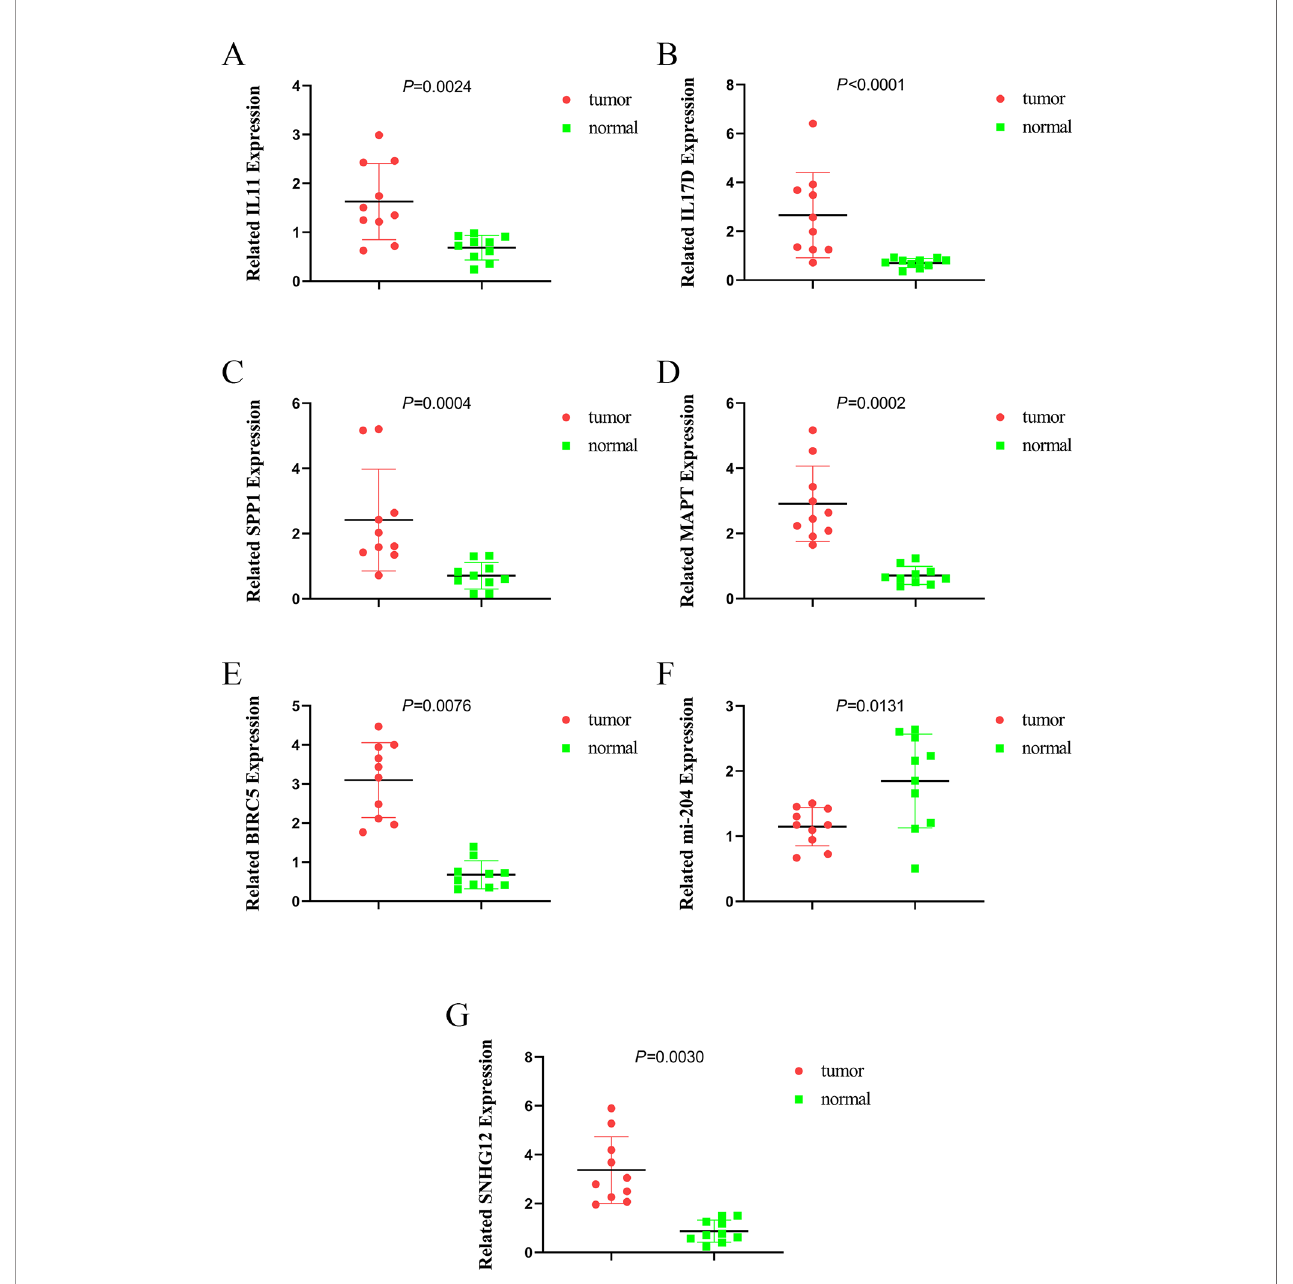
FIGURE 12 | The expression of IL11, IL17D, SPP1, MAPT, BIRC5, miR-204, and SNHG12. (A) the expression of IL11, (B) the expression of IL17D, (C) the expression of SPP1, (D) the expression of MAPT, (E) the expression of BIRC5, (F) the expression of miR-204, and (G) the expression of